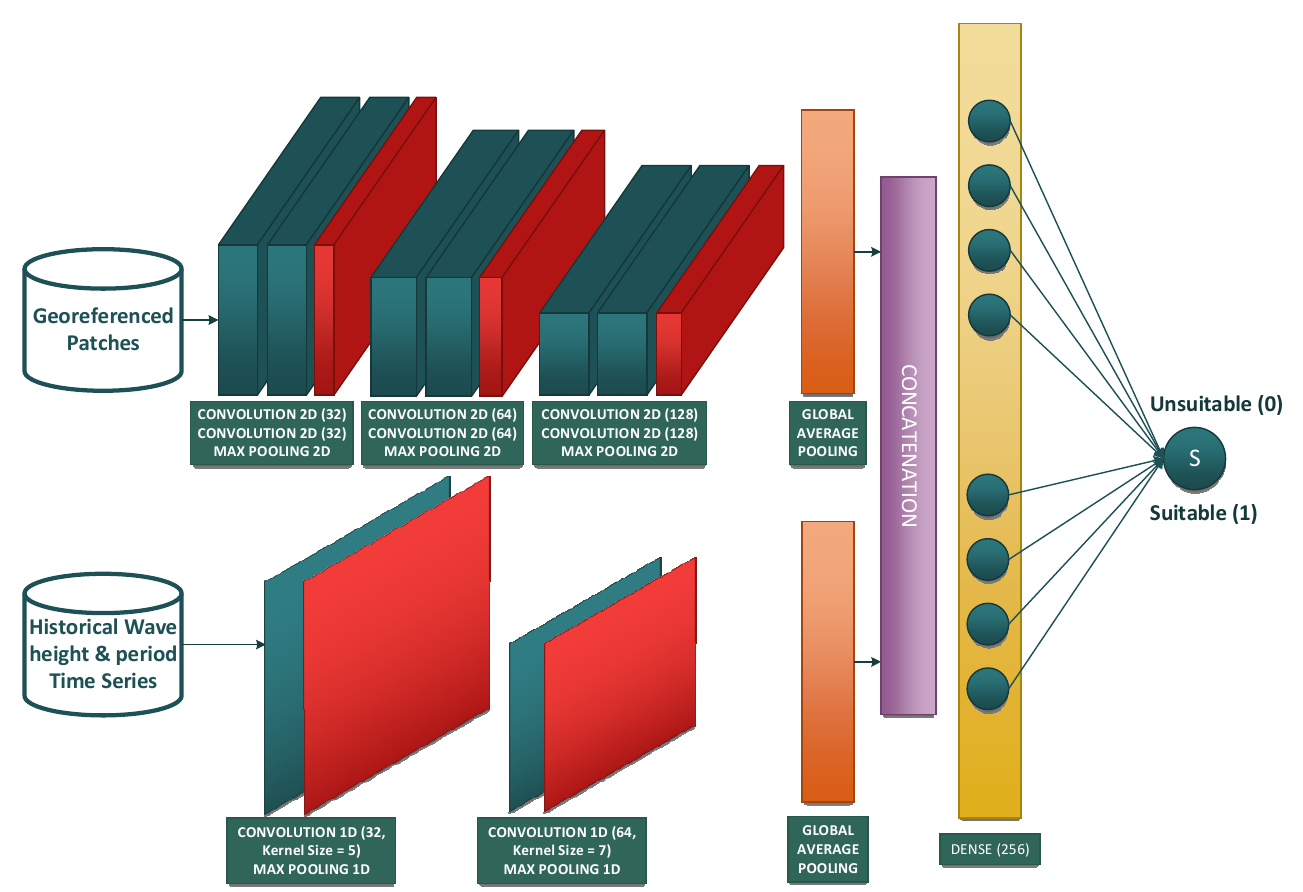
Figure 3. Data fusion Neural Network Architecture—Mode I.